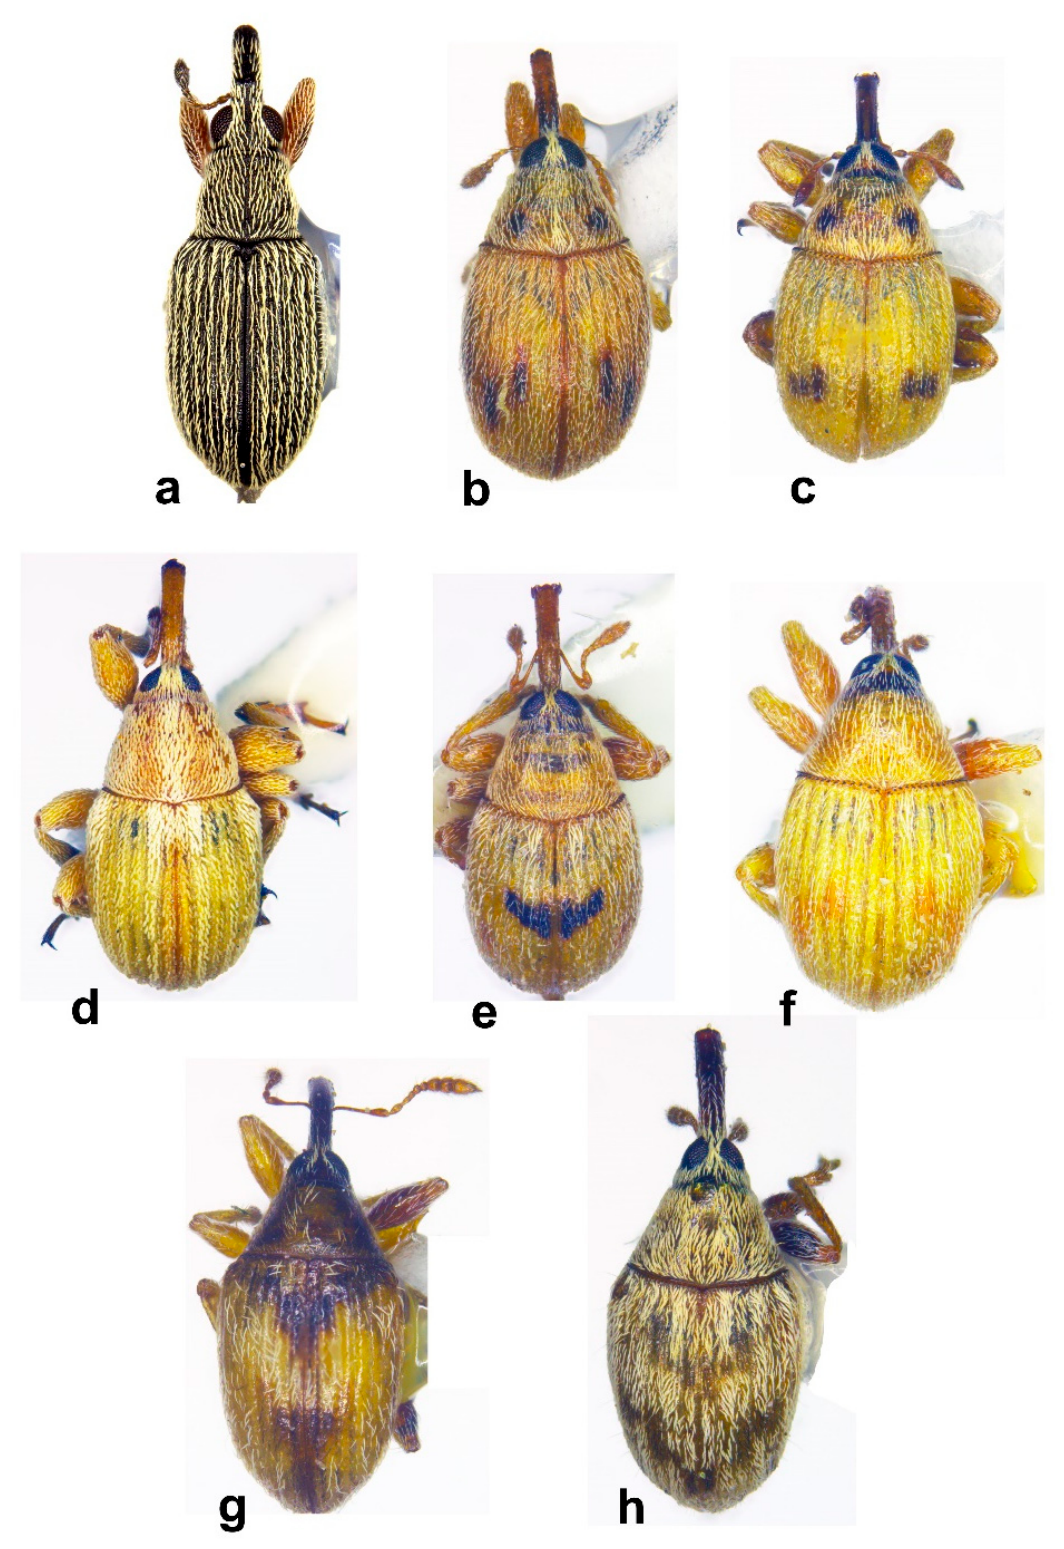
Figure 5. Habitus in dorsal view of ( a ) Squamapion delagrangei , male; ( b ) Allomalia quadrivirgata , male; ( c ) Allomalia setulosa , male; ( d ) Corimalia latifrons , male; ( e ) Corimalia schatzmayri , female; ( f ) Corimalia torretrassoi , male; ( g ) Nanomimus sp., male; ( h ) Nanophyes sp. 1, male (not on the same scale).